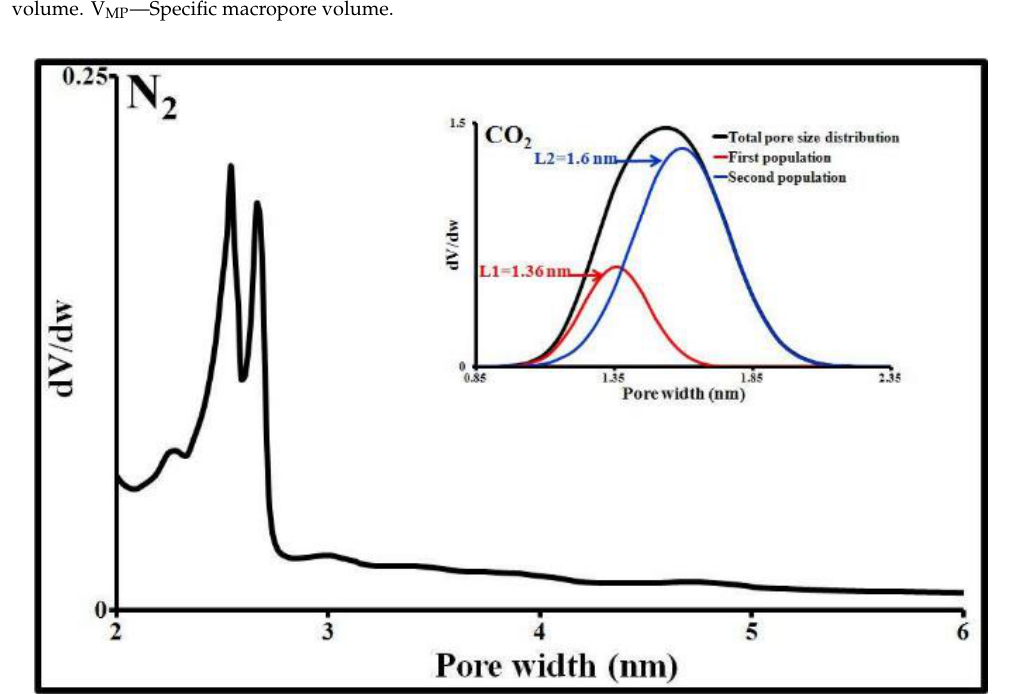
Figure 2. Pore size distribution obtained by N 2 desorption at 77 K and CO 2 adsorption at 273